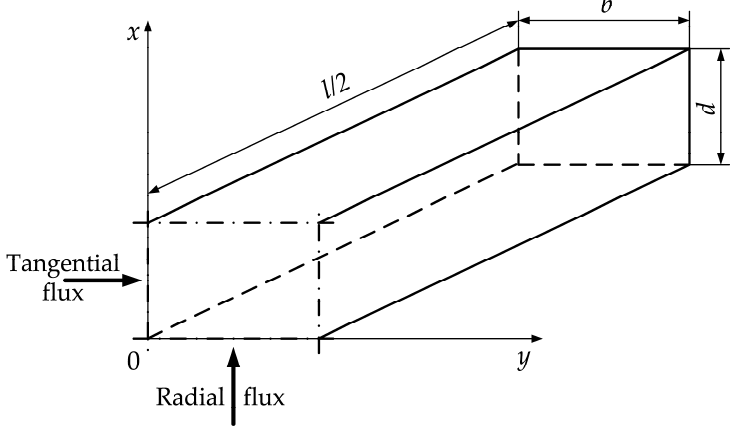
Figure 1. Positioning of the prism’s dimensions and heat fluxes during the steaming process.